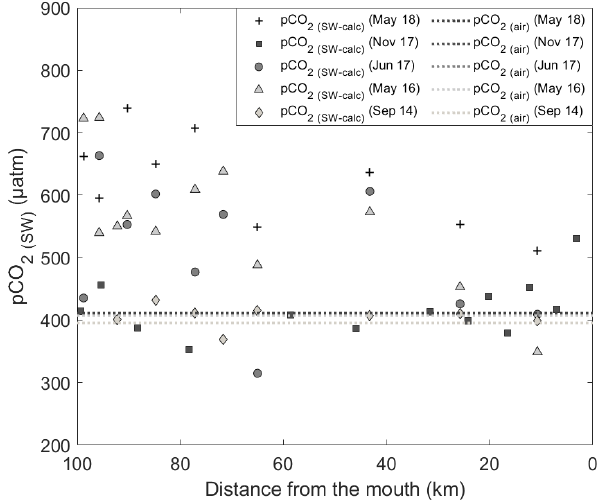
Figure 4. Spatial distribution of surface water p CO 2(SW-calc) in September 2014, May 2016, June 2017, November 2017 and May 2018. Dashed lines represent the p CO 2 ( air ) in the sampling months (respectively, 396ppm in September 2014, 407ppm in May 2016, 408ppm in June and November 2017, and 411ppm in May 2018). Data points above the lines indicate that waters are sources of CO 2 to the atmosphere, whereas those below the lines identify waters that are sinks of atmospheric CO 2 .